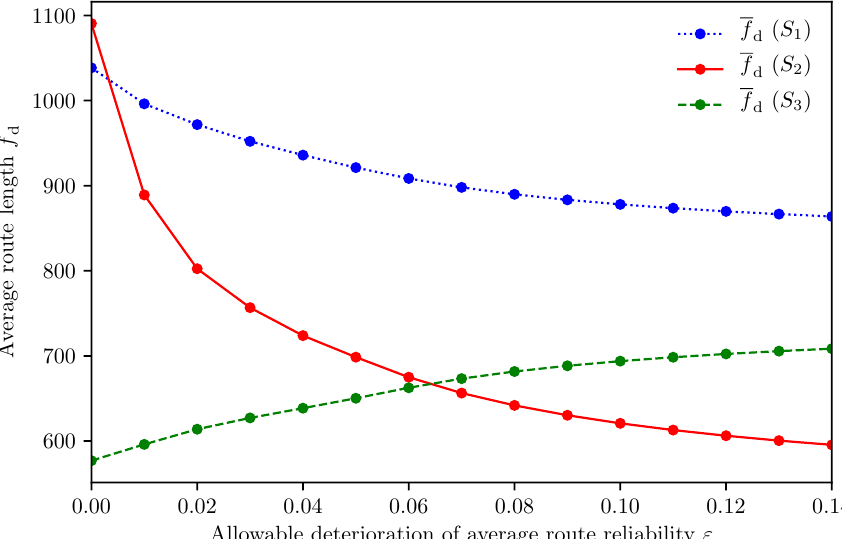
Figure 8. Relationship between ε and f